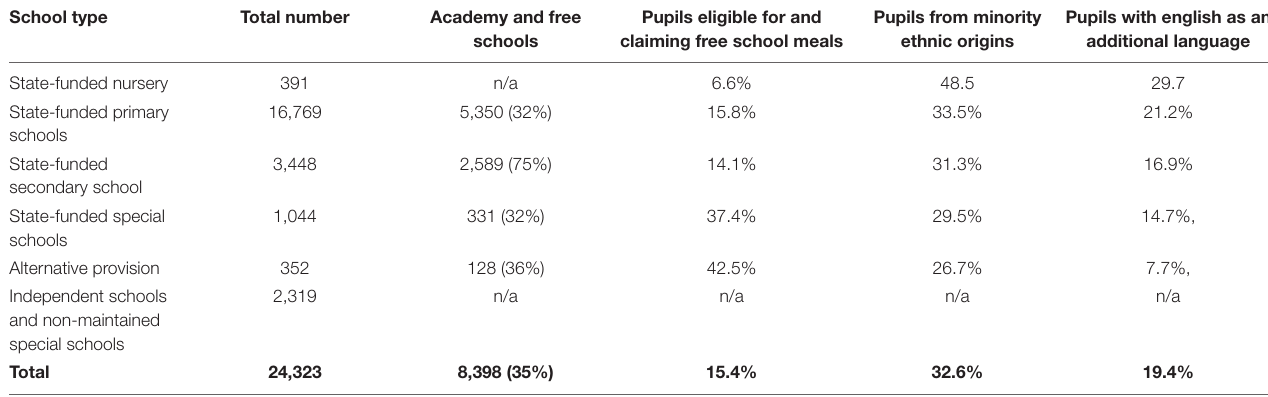
TABLE 2 | Characteristics of schools in England and their pupil